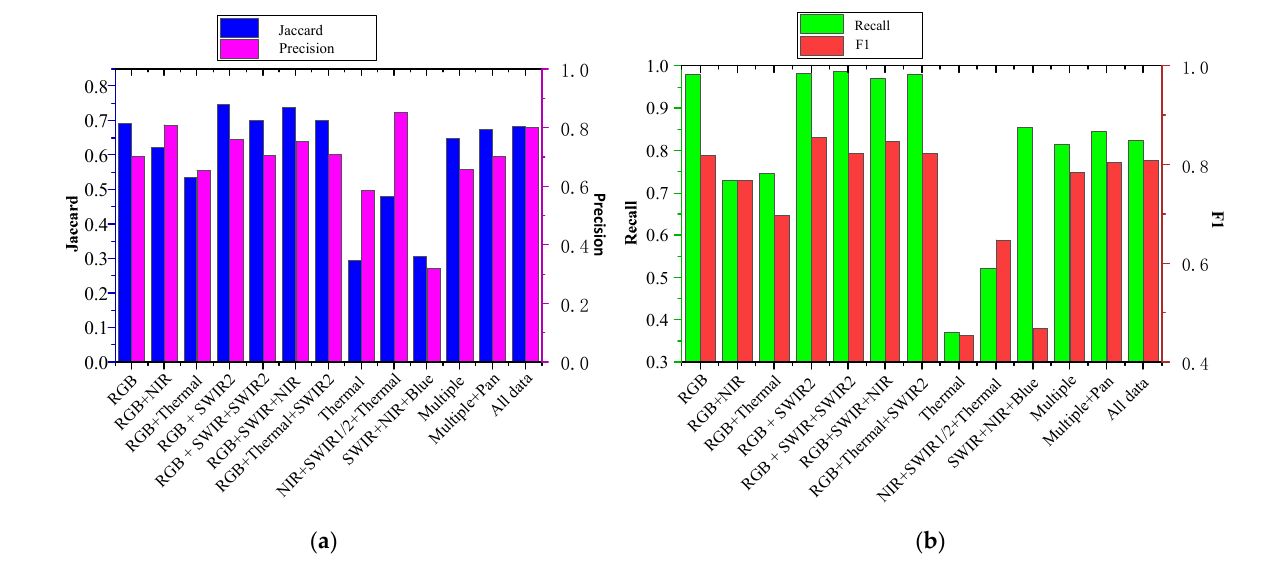
Figure 9. The segmentation results of smoke with variety bands combination. ( a ) The result of Jaccard and Accuracy; ( b ) The result of recall and F1. Table 6. The segmentation results of different bands combination.